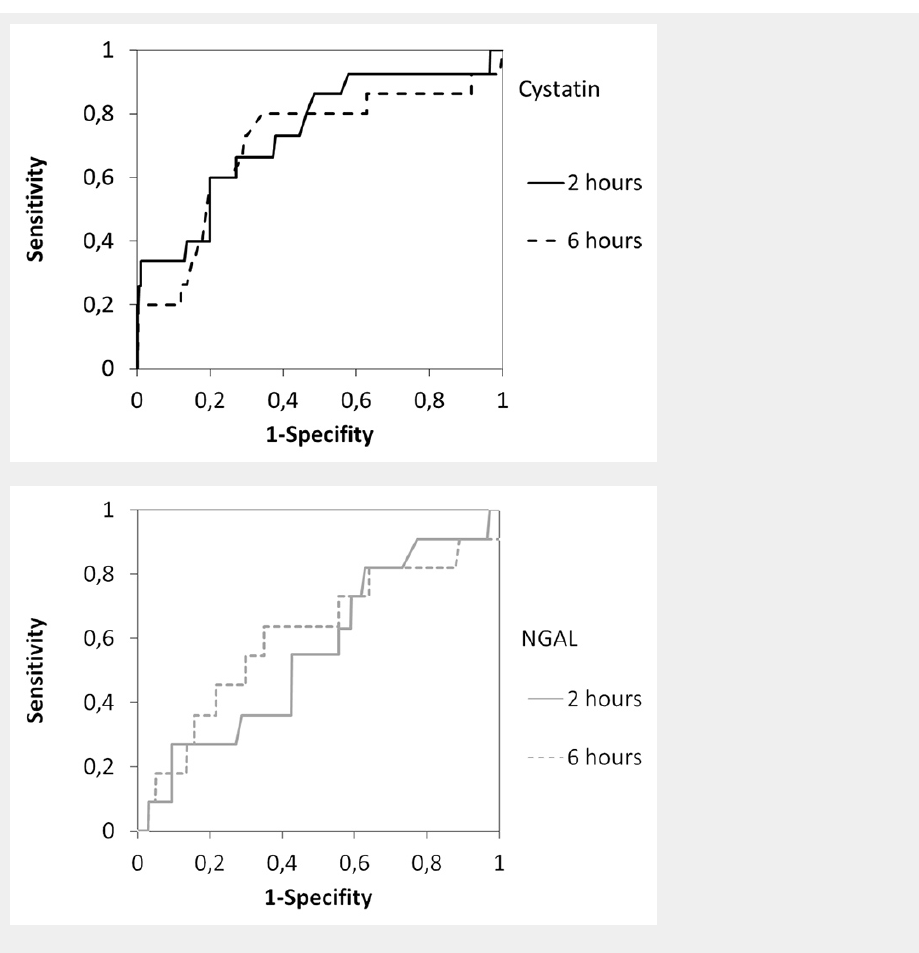
Figure 5 Receiver operating characteristic (ROC) curve analysis using 2h and 6h postoperative serum Cystatin C (a) and urine NGAL (b) concentration in the patient cohort. The area under the ROC curve for Cystatin C was 0.74 (2h; p = 0.003) and 0.71 (6h; p = 0.009), respectively. The area under the ROC curve for urine NGAL was 0.56 (2h; n.s.) and 0.60 (6h; n.s.). Optimal sensitivity and specifity occurred at a value of 0.995 mg/l for 2h Cystatin